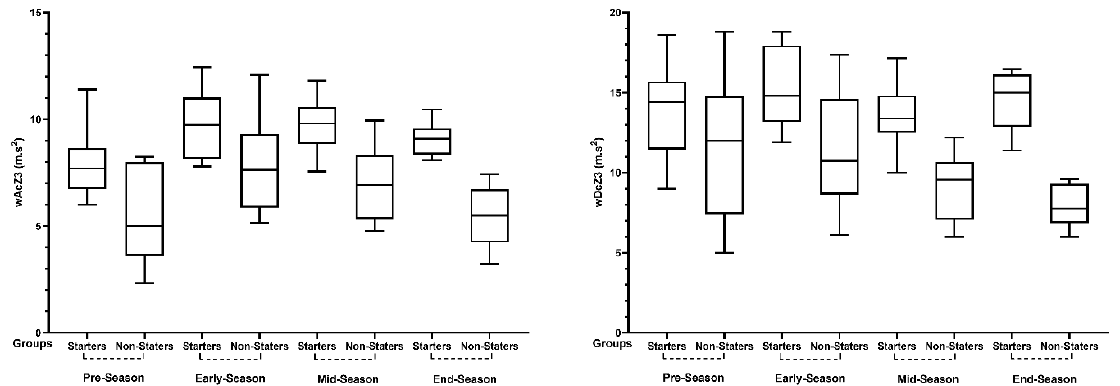
Figure 4. Pairwise comparisons between season periods in wAcZ3, The average weekly time spent on the acceleration threshold of zone 3 (<4 m · s 2 ) and wDcZ3, The average weekly time spent on the deceleration threshold of zone 3 (< − 4 m · s 2 ). m · s − 2 , meters per second squared.